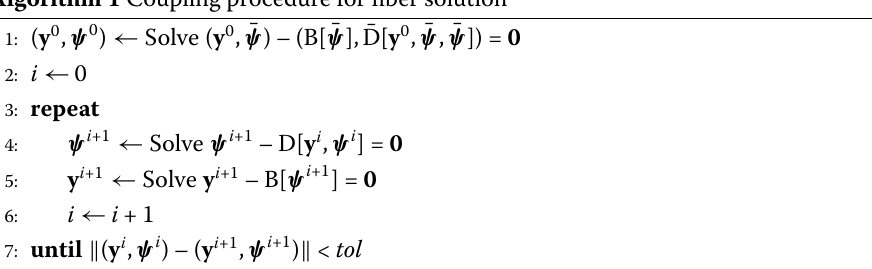
Algorithm 1 Coupling procedure for fiber